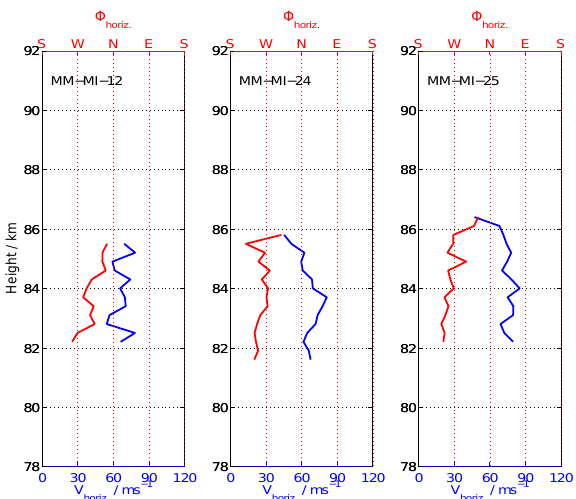
Fig. 6. Horizontal wind speed and direction as half-hourly mean measured by the Spaced-Antenna method.